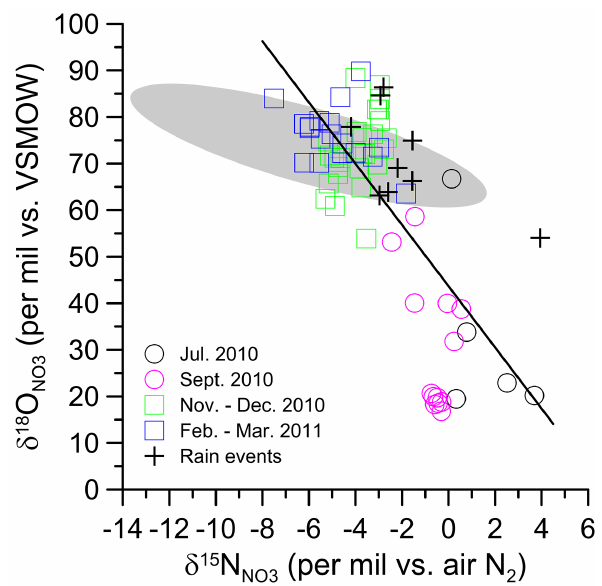
Fig. 4. Correlation between δ 15 N NO deposition as well as rain-mixing bulk deposition. The solid line indicates the regression line for the entire data set. The shaded area covers the distribution of δ 15 N and δ 18 O values of precipitation nitrate observed at Bermuda (32.27 ◦ N, 64.87 ◦ W; Hastings et al.,